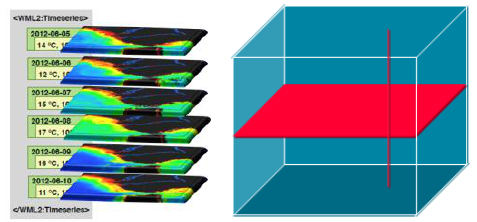
Figure 11. Sliced datacube representation in WaterML (let) vs. direction-invariant coverage model